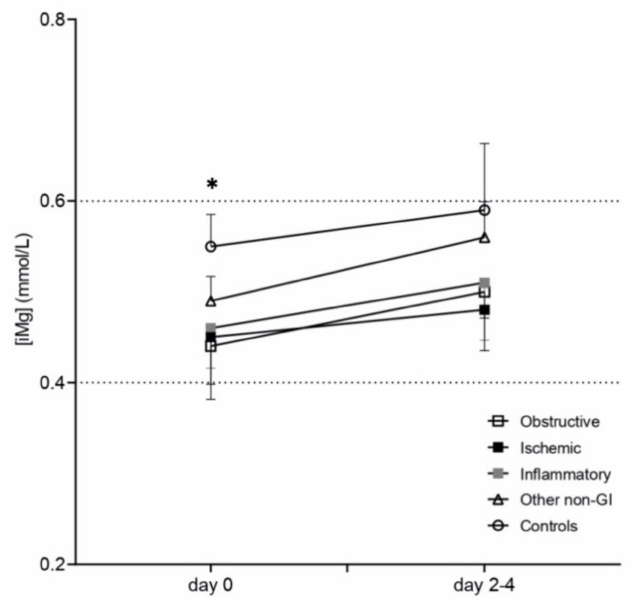
Figure 1. Mean ( ± 2SE) (iMg) (mmol/L) over time (plotted in two time points: day 0 and day 2–4) in sick adult horses (open square = obstructive, black square = ischemic, gray square = inflammatory, open triangle = non-GI disorders, open circles = controls). Horizontal dotted lines from the left Y axes show the reference range for (iMg) in adult horses. * obstructive and ischemic are significantly different from control